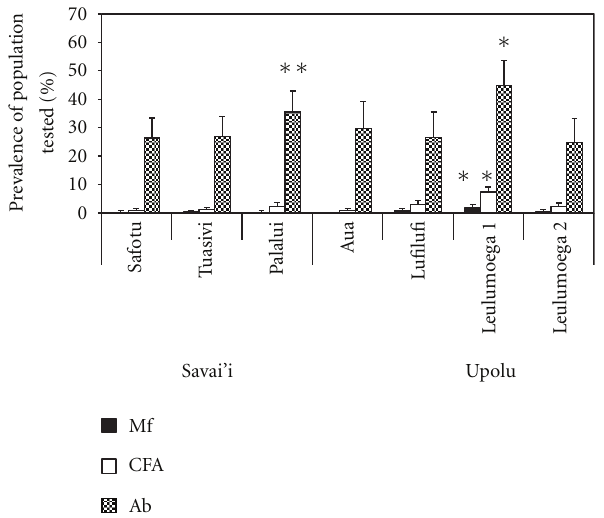
Figure 3: Mf, CFA, and antibody prevalence across the health districts in Samoa. Leulumoega 1 recorded a significantly higher Mf ( ∗ ), CFA ( ∗ ), and antibody (Ab) prevalence in children ( ∗ ) than the other districts ( χ 2 = 46 . 9; df = 6; P < 0 . 001), ( χ 2 = 124 . 9; df = 6; P < 0 . 001), ( χ 2 = 20 . 6; df = 6; P < 0 . 001). Similarly, Palalui recorded a significantly high antibody (Ab) prevalence ( ∗∗ ) in children ( χ 2 = 20 . 6; df = 6; P < 0 .